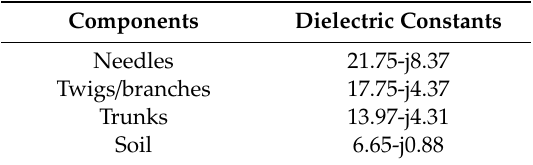
Table 6. The dielectric constants of components in Ku-band.